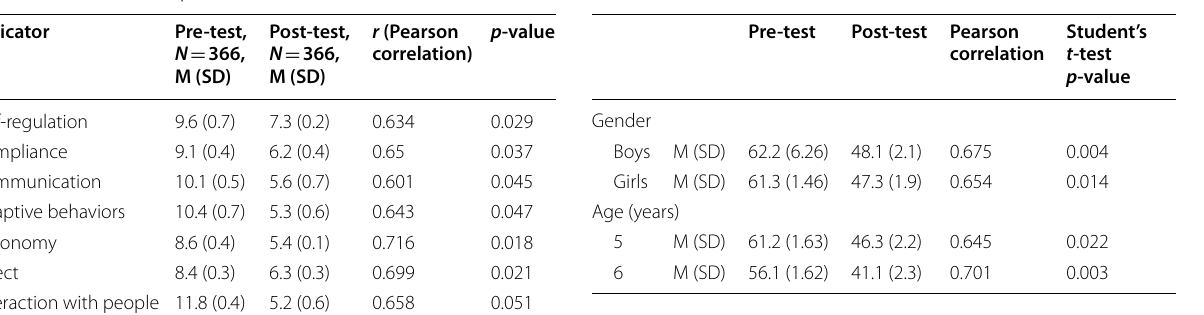
Table 3 Statistical evaluation results for the gender and age